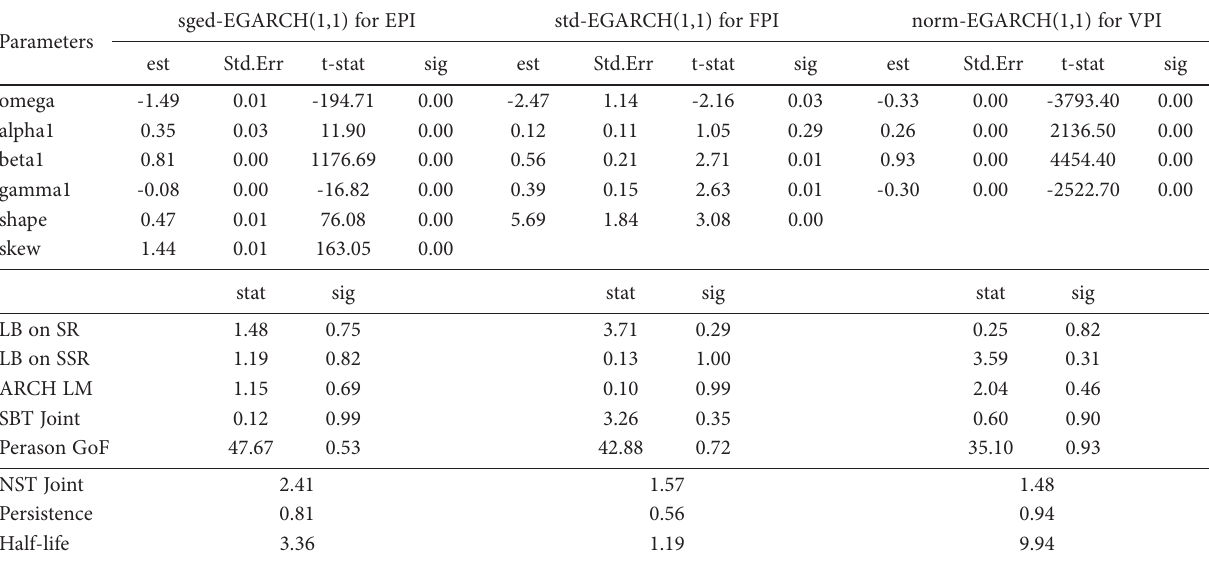
Table 3. The Parameter Estimation of EGARCH(1,1) Models for Price Indices.